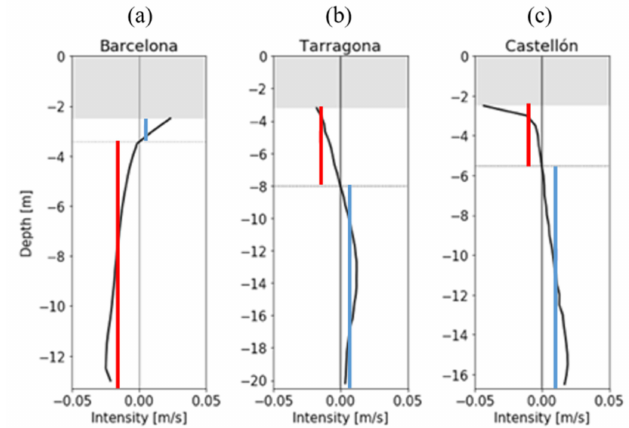
Figure 7. Time-averaged vertical profiles measured in the Barcelona ( a ), Tarragona ( b ), and Castell ó n ( c ) harbours (in black). Averaged outflow velocities (lines in red) and averaged inflow velocities (lines in blue). The ADP location is shown in Figure